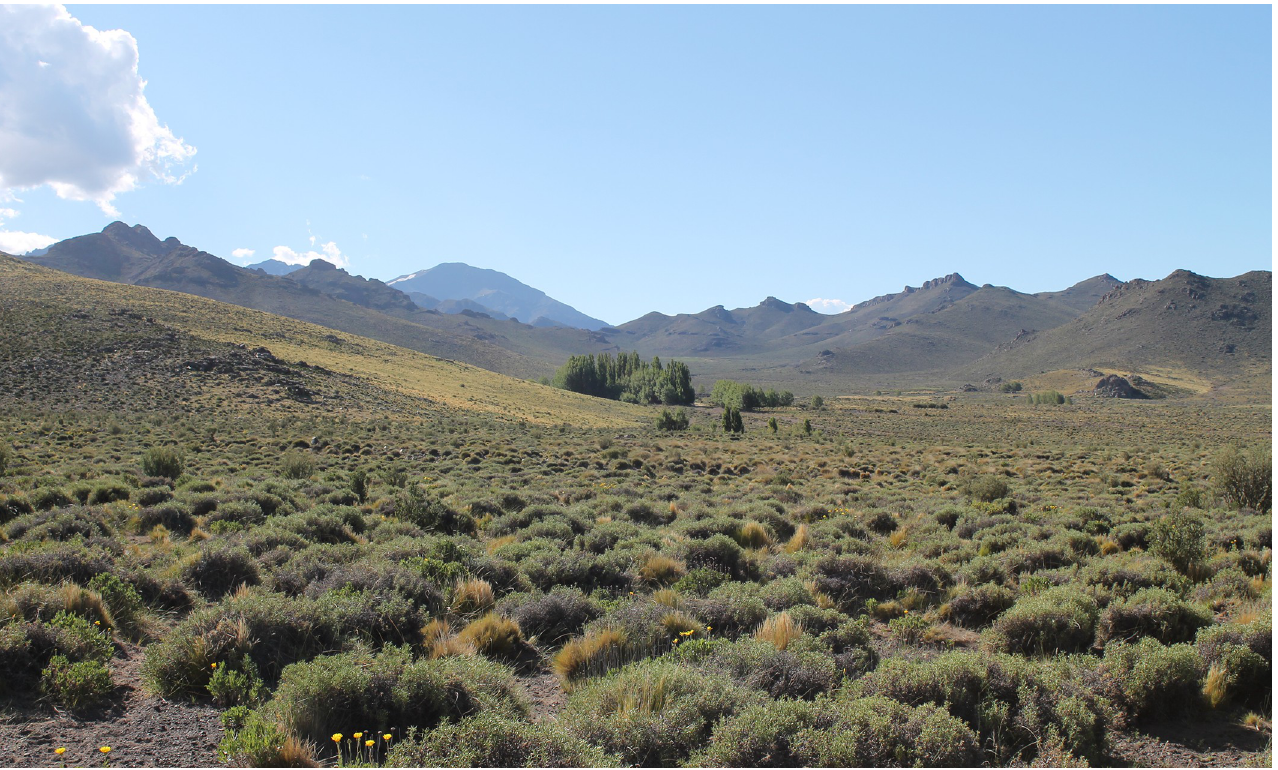
Fig 9. Epigean landscape in the Payunia, around Do ñ a Otilia cave. Plant cover shows the characteristic pulvinate shrubs on sandy soil; the Sierras de Palauco are on the background.